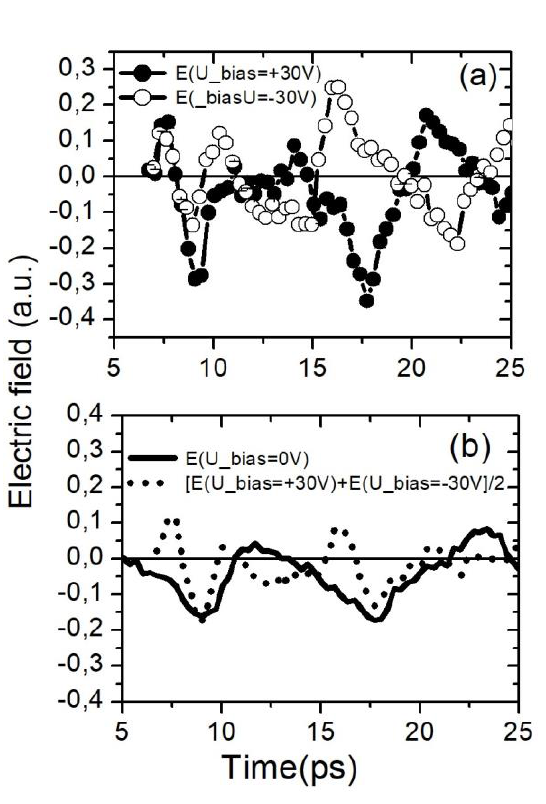
Fig. 2. Waveforms of the THz pulses The observed waveforms contain some additional signal, which does not change its polarity with the voltage. To reveal this part we have summarized the signals, observed with +30 V and -30V voltages. Half of this sum is shown in Fig.2b (see the dotted